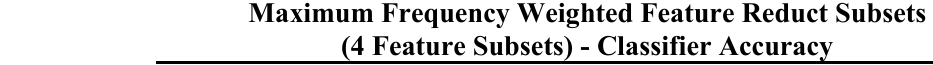
Minimal reduct subset (4 - features)